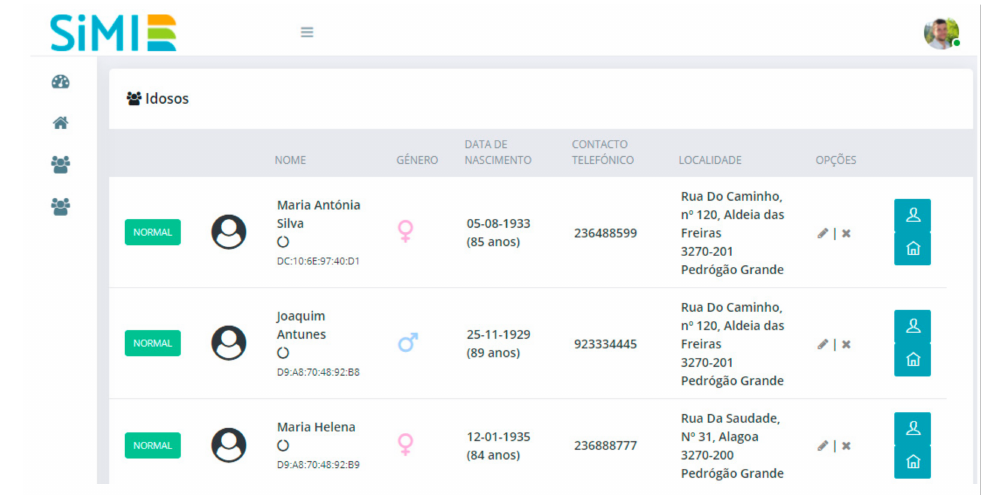
Figure 11. The elderly’s management page.